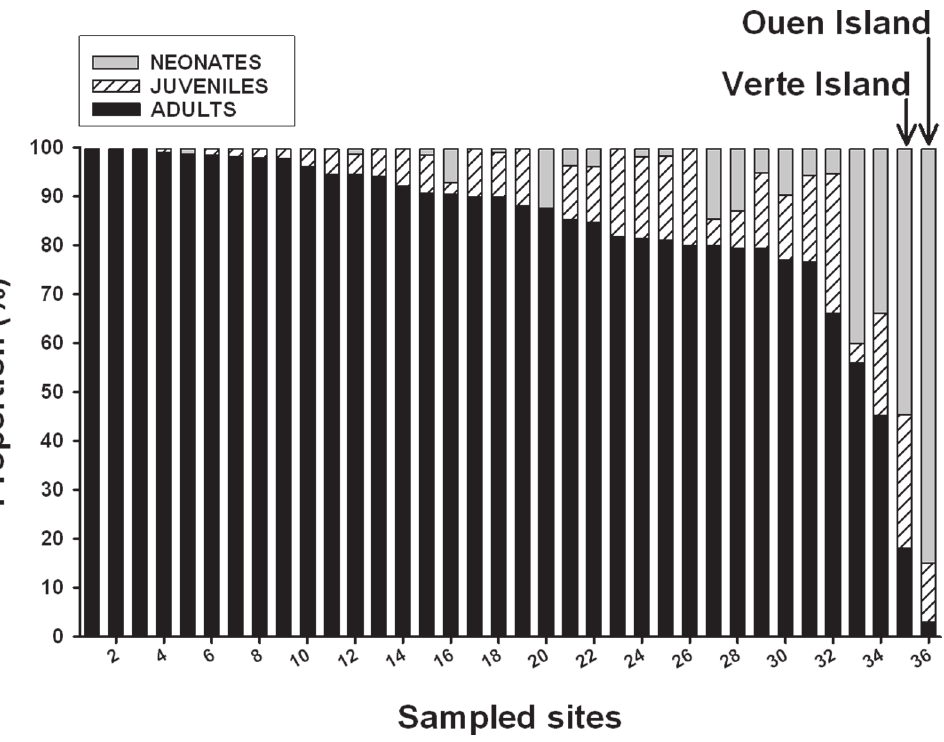
Figure 1. Proportion of neonate (grey), juvenile (hatched) and adult (black bars) sea kraits observed in different populations of New Caledonia (N=36 sites where the number of snakes exceeded 10 [Mean=313 snakes per site, total N=11,273 observations]). The populations have been ranked according to the proportion of adults. The first 20 sites are represented by small flat sandy coralline islets while the last four sites have an igneous or rocky substrate and are situated near, or on the shore of the mainland, see [31] for map details.